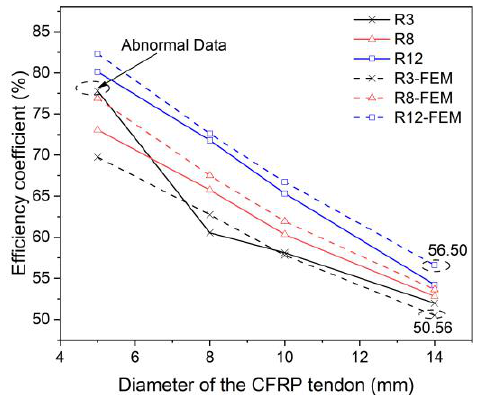
Figure 15. Curves of diameter and efficiency coefficient.